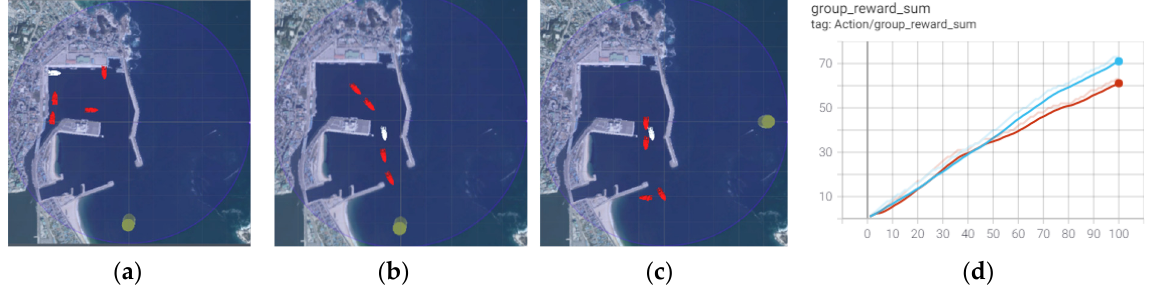
Figure 12. ( a ) Initial experiment environment. The ships are artificially arranged in front and at the back to adjust the interval between four outward vessels. ( b ) ILFAS RL results. The ships sail on the right path. ( c ) Random RL results. The ships wait in habor and sail on the fast path. ( d ) The success rate to a destination in 100 episodes was 70% in The ILFAS (Blue) and 60% in the random RL (Red).